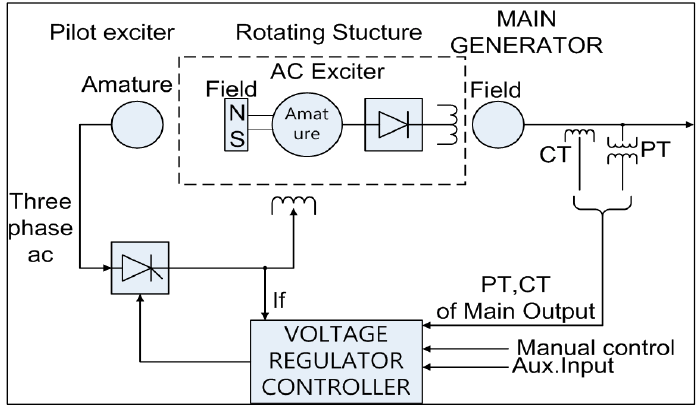
Figure 3. Generator output voltage control method for alternating current rotary excitation system.